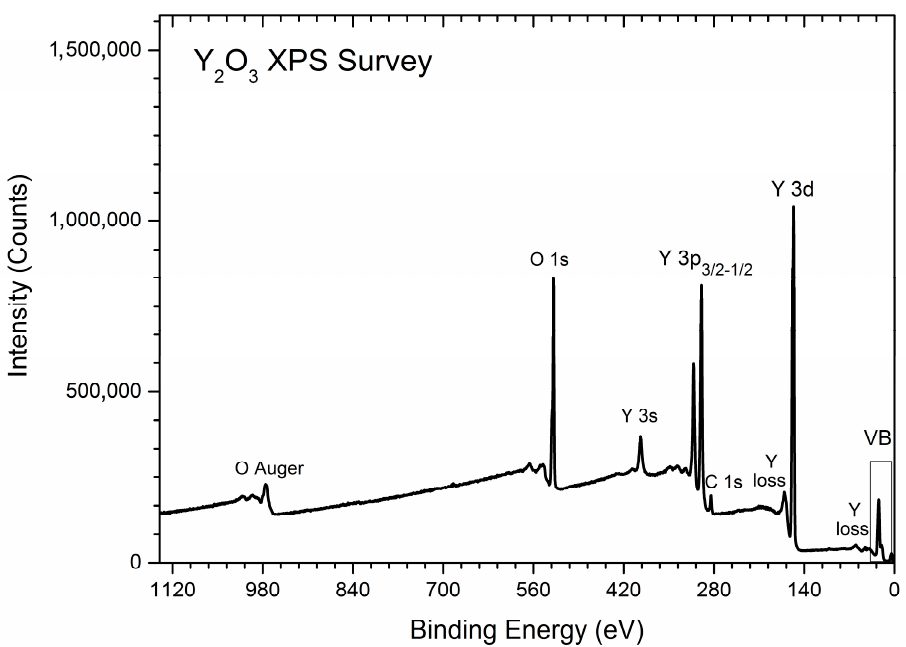
Figure 2. XPS Survey spectrum identification of the Y 2 O 3 sample under study.